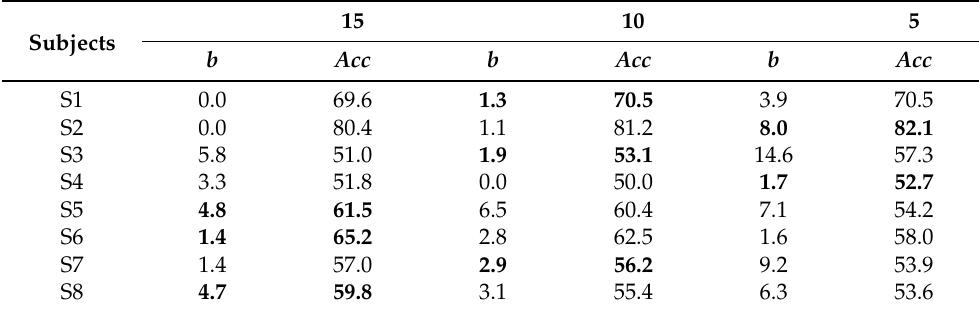
Table 6. The best electrodes for the selection of 15, 10 and 5 are indicated respectively underlined with colors: green, blue and red. The best results of the three electrode configurations have been highlighted in bold.